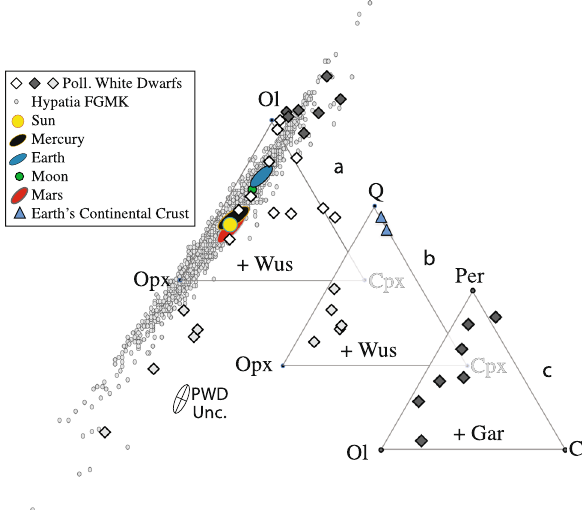
Fig. 3 Rock Classi fi cations (old and new). Bulk Silicate Planets (Mg + Si + Ca + Fe) of PWDs are recast as mineral components and plotted in a the classic ternary ultrama fi c rock classi fi cation 39 , and two new ternary diagrams ( b , c ) that can describe PWDs as a set of positive mineral components. “ PWD Unc. ” indicates the propagated average uncertainty in PWD compositions. These ternaries show the relative proportions of the minerals olivine (Ol; (Mg,Fe) 2 SiO 4 ), orthopyroxene (Opx; (Mg,Fe) 2 Si 2 O 6 ), clinopyroxene (Cpx; Ca(Mg,Fe)Si 2 O 6 ), periclase (Per; MgO), and quartz (Q; SiO 2 ). The symbols “ + Wus ” and “ + Gar ” indicate that all rocks within a given ternary respectively contain wüstite (Wus; FeO) or pyrope garnet (Gar; Mg 3 Al 2 Si 3 O 12 ). Points falling outside a ternary contain a negative amount of one or more indicated minerals and must be recast using a new set of minerals to obtain positive proportions. Mantle compositions of Earth, Moon Mars, and Mercury fall within ( a ), as do BSPs calculated using FGMK star compositions. Many PWDs fall outside of ( a ), but can be described as positive fractions of either ( b ) Q + Opx + Cpx or ( c ) Per + Ol + Cpx ( c ). Even in a , only a few PWDs are mineralogically similar to the inner planets or exoplanets derived from FMGK stars. In b , Q-bearing PWD mantles have too much Opx (too much MgO) to represent continental crust, which plots at much higher Q contents. Suggested rock names for the new classi fi cation schemes in b and c are given in Table